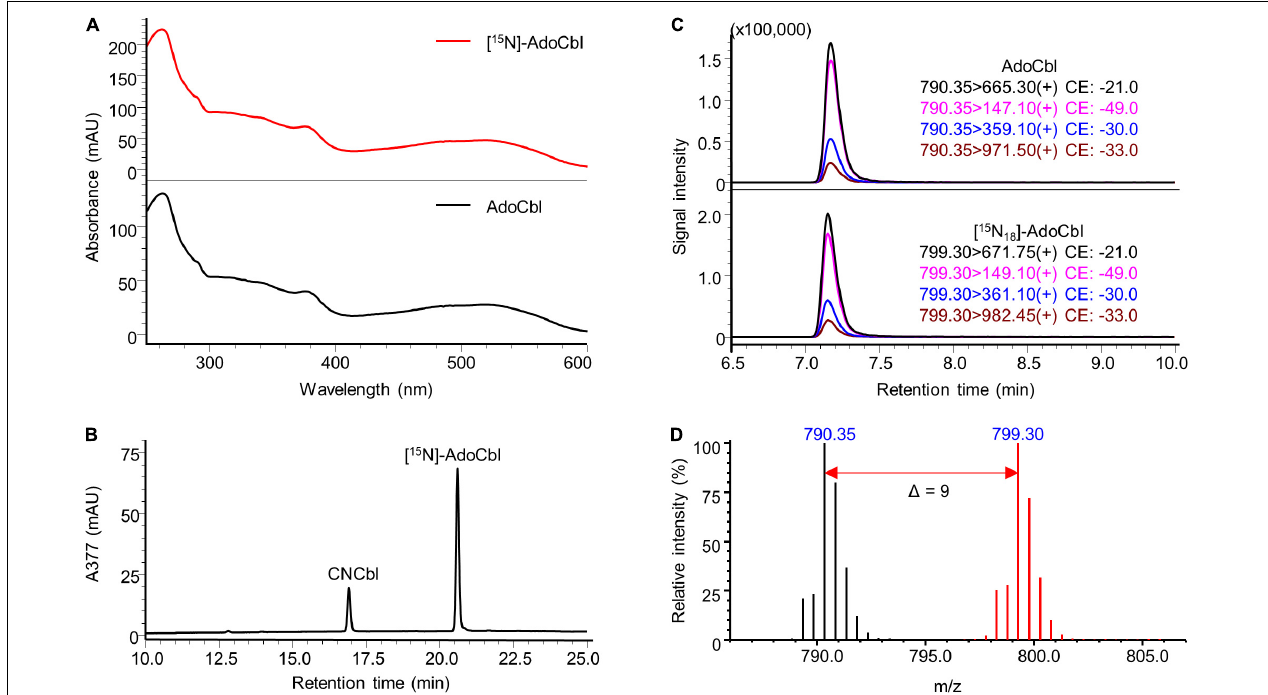
FIGURE 4 | Characterisation of prepared [ 15 N]-AdoCbl. (A) UV-Vis spectrum of the prepared [ 15 N]-AdoCbl in comparison to that of the AdoCbl standard. (B) HPLC-DAD analysis at a wavelength of 377 nm of the prepared substance showed a major peak at the same retention time of unlabelled AdoCbl standard (see Supplementary Figure 6 ). CNCbl shown on the chromatogram was added as internal standard to determine the absolute concentration of [ 15 N]-AdoCbl. (C) LC-MS/MS analysis of [ 15 N]-AdoCbl monitoring mass transitions corresponding to [ 15 N 18 ]-AdoCbl (lower trace). The LC-MS/MS chromatogram of unlabelled AdoCbl is shown as a reference (upper trace). (D) Overlaid mass spectra of [ 15 N]-labelled AdoCbl (red) and unlabelled AdoCbl (black). The mass shift in [M + 2H] 2 + values indicated by the red arrow confirmed the labelling of 18 nitrogen atoms. MS spectra were acquired in selected ion monitoring (SIM) mode with a m/z interval of